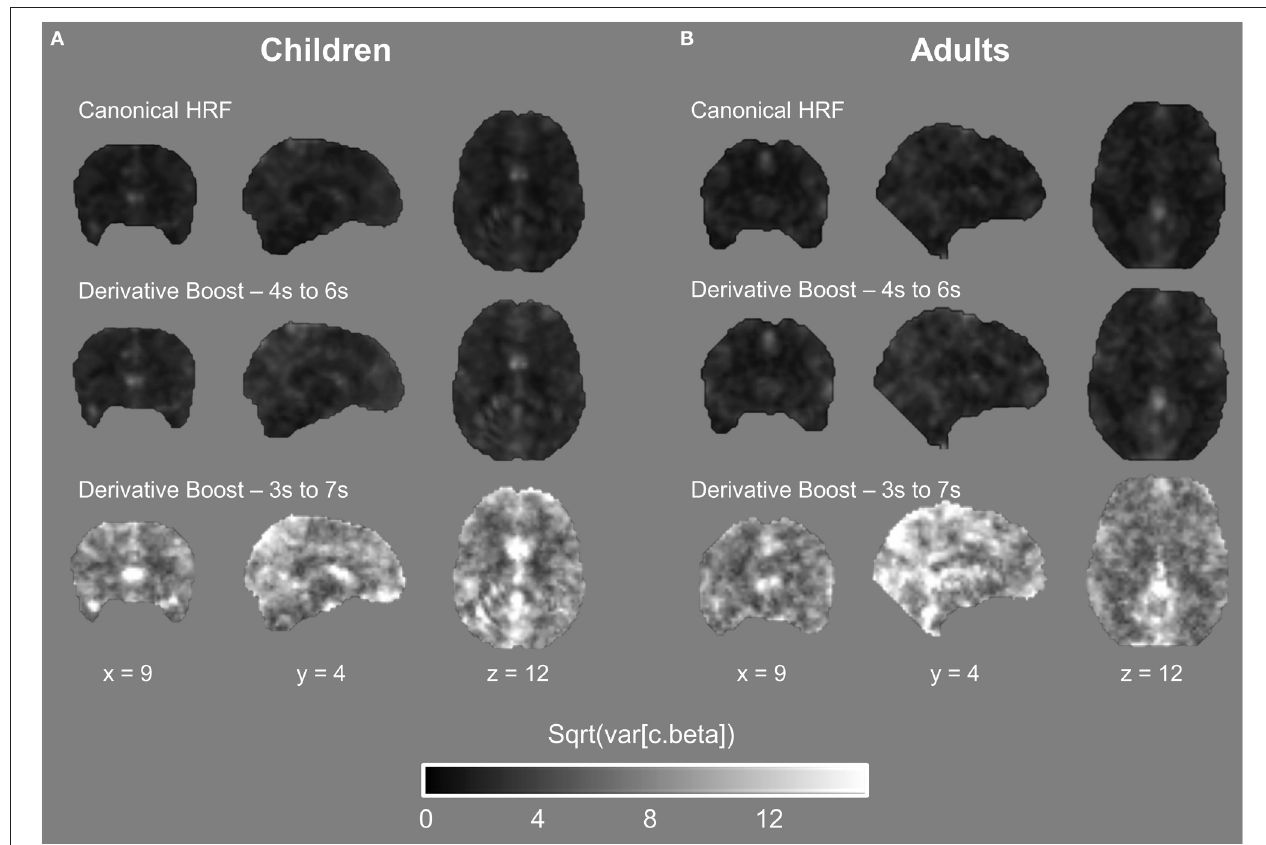
FIGURE 5 | Between-subject variability maps in the proprioceptive 100Hz condition expressed as a function of the model used. (A,B) Both children and adults showed an increase in variability when using the derivative boost, especially for the full derivative boost (peaking approximately between 3 and